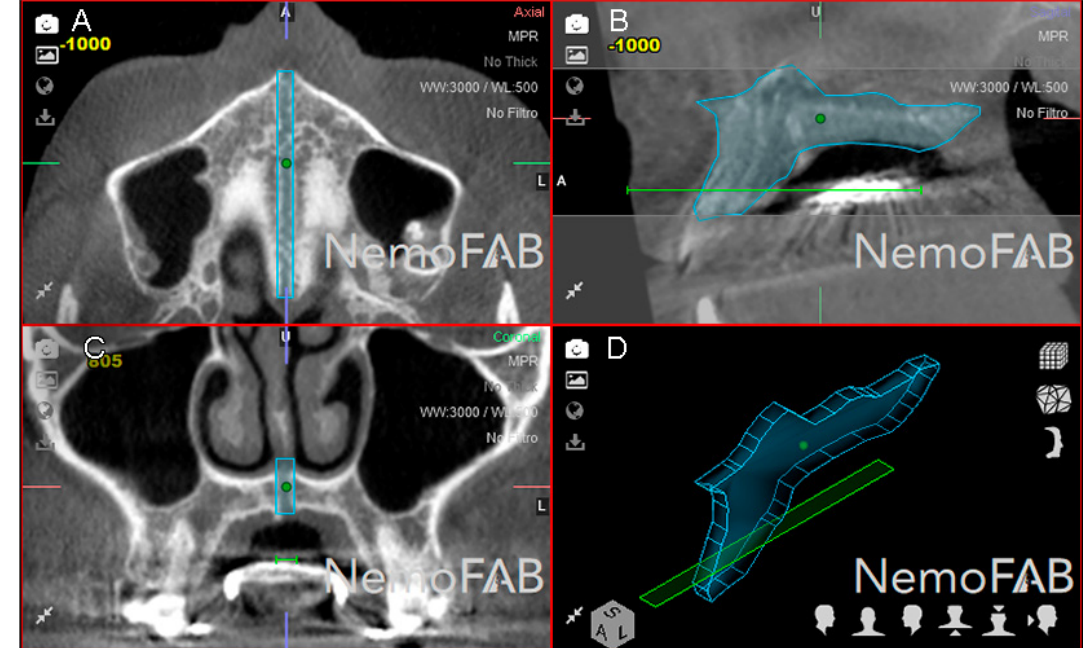
Figure 4. - ( A ) Boundaries of the palatine suture (blue line) after the RME procedure through McNamara appliance with the seed point inside, at transversal plane, ( B ) sagittal plane, ( C ) coronal plane and ( D ) at three-dimensional reconstruction.